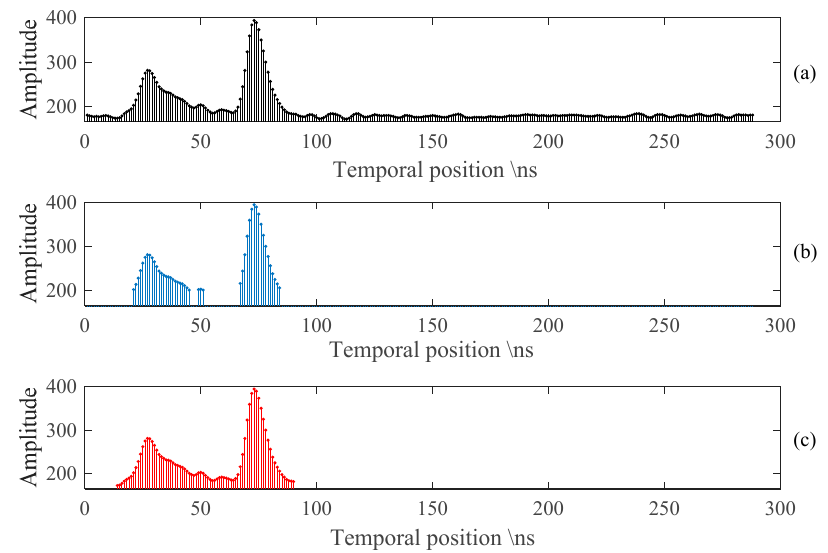
Figure 5. Selection of the effective part of the echo waveform. ( a ) Original waveform. ( b ) Aquarius data truncated by the single threshold. ( c ) Effective part of the waveform obtained by the method described in this paper. No interruptions occur in the interval.